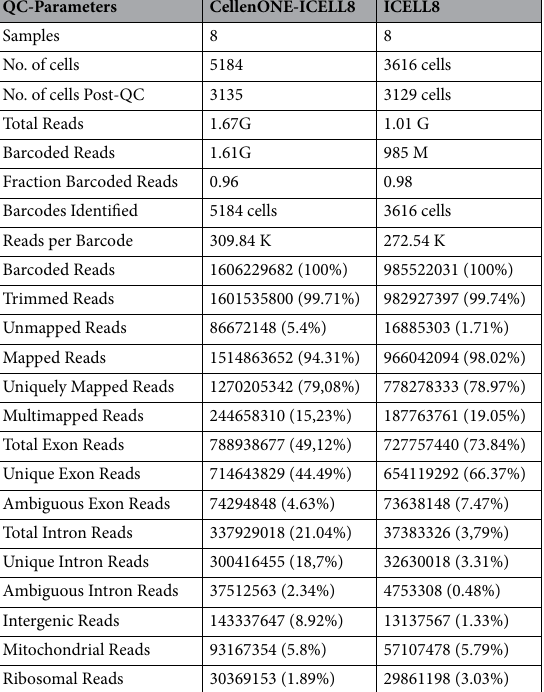
Table 2. Read parameters of the two scRNA-seq approaches CellenONE-ICELL8 and ICELL8 (CogentDS).